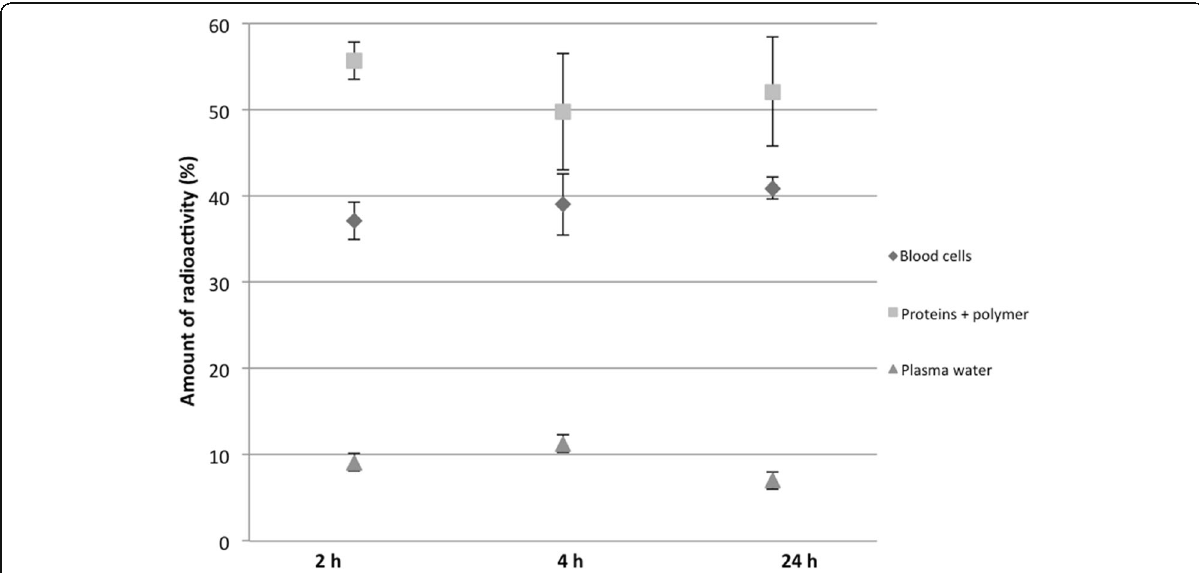
Fig. 10 Distribution of [ 44 Sc]Sc-31c in the blood for up to 24 h ( n = 3). Data is expressed as percentage of the amount of radioactivity that was present in the whole blood sample (mean ±